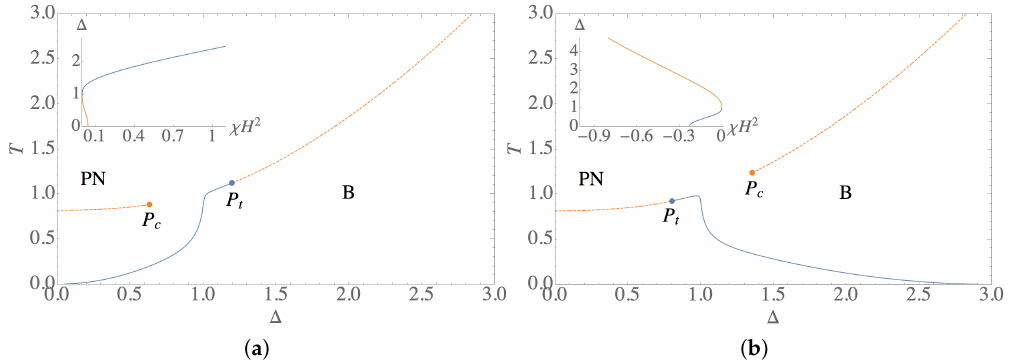
Figure 2. Main plots: Phase diagrams in the presence of a field of intensity H = 0.1, with the choice χ 1 ≡ χ (cid:54) = 0 and χ 2 = χ 3 = 0, both for χ = 1 ( a ) and χ = − 1 ( b ). The Landau point is replaced by a simple critical point P c and a tricritical point P t . The regions corresponding to the paranematic (PN) and the biaxial (B) phases are also indicated. Insets: Dependence of the values of ∆ at P c (orange curve) and P t (blue curve) on the product χ H 2 . Apart from small shifts produced by the field, a combined parametric T × ∆ plot obtained from the values of T and ∆ at P c and P t as χ H 2 is varied would closely follow the first-order lines in Figure 1.